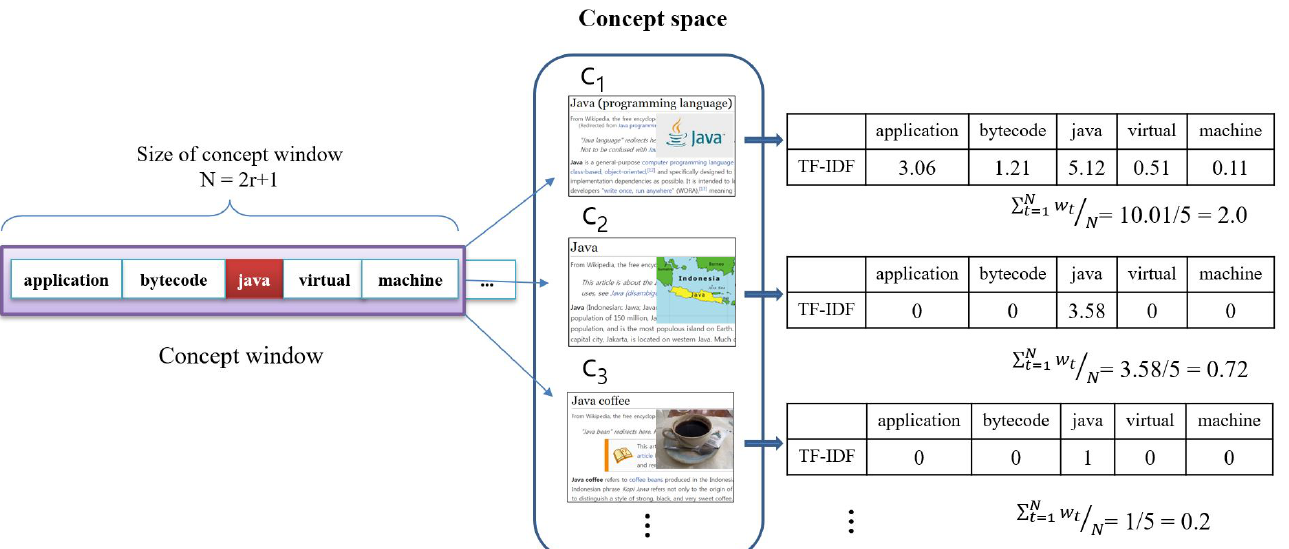
Figure 2. Concept window for generating concept vectors.